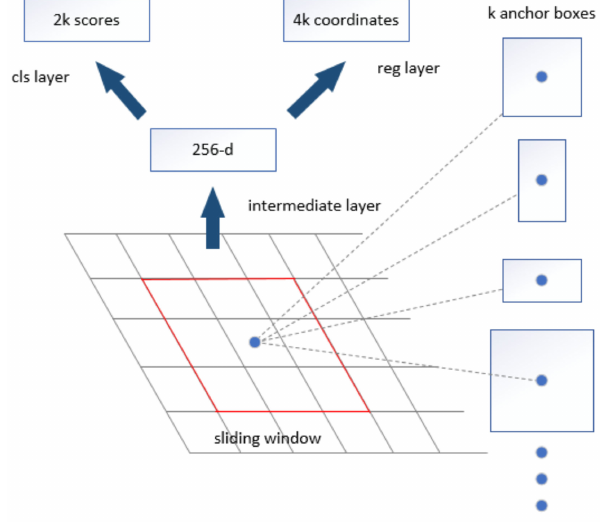
Figure 3. Region Proposal Network